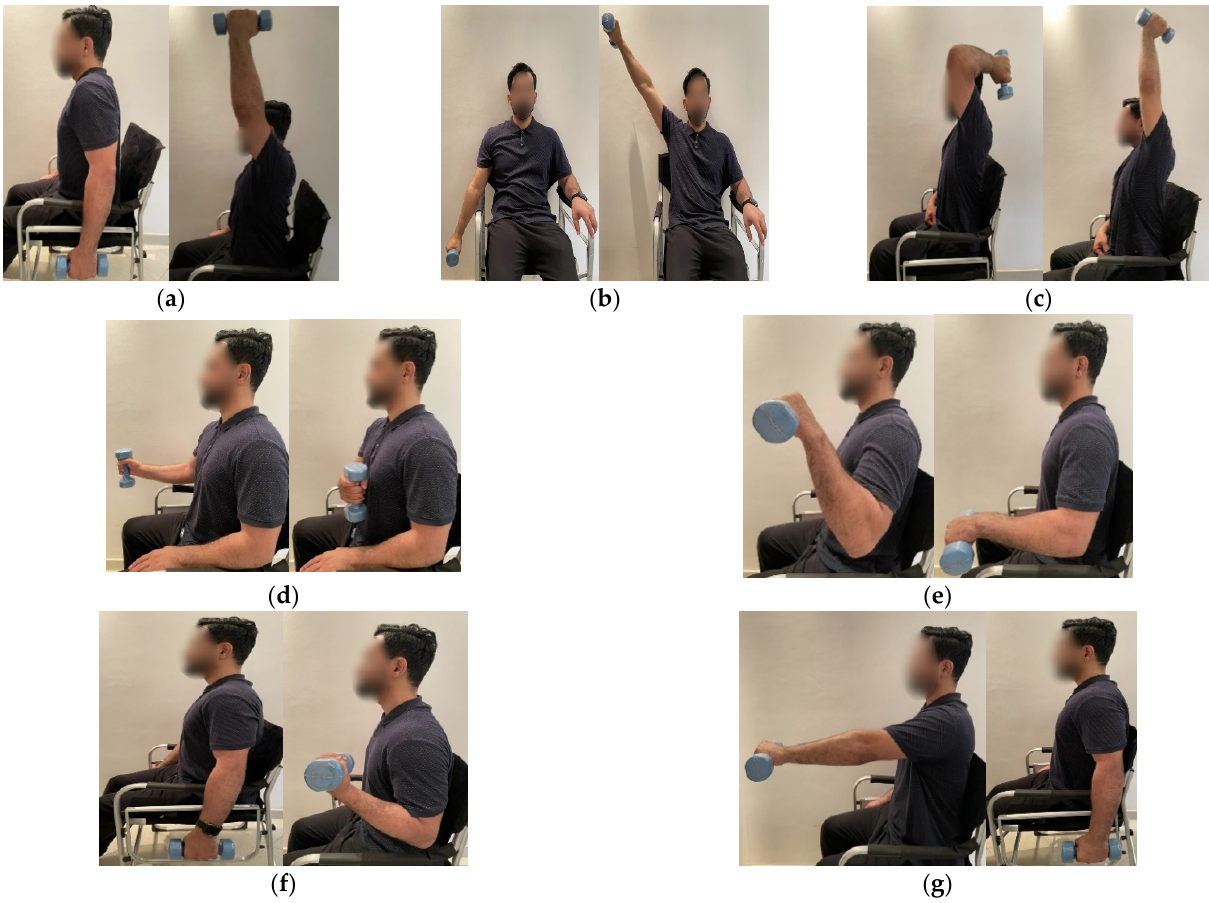
Figure 3. Physical activities used to rehabilitate spinal cord injury (SCI) patients: ( a ) shoulder flexion (SF); ( b ) shoulder abduction (SA); ( c ) elbow extension (EE); ( d ) shoulder internal rotation (SIR); ( e ) shoulder external rotation (SER); ( f ) elbow flexion (EF); and ( g ) shoulder extension (SE).